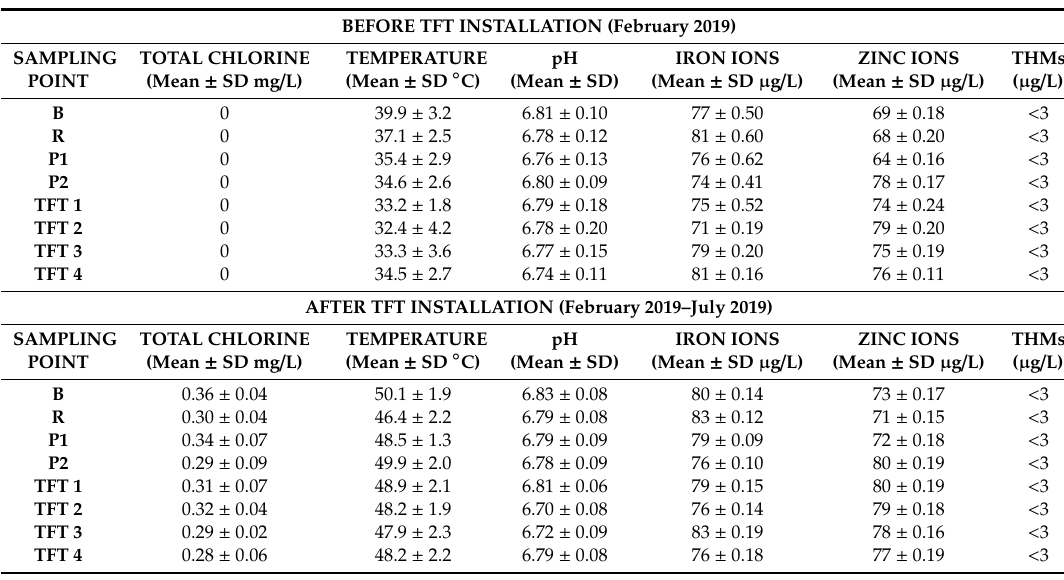
Table 4. Mean values of physical–chemical and chemical parameters assessed at each sampling points before and after TFT installation in Hospital 4. (B = boiler; R = recirculation; P1 = point 1; P2 = point